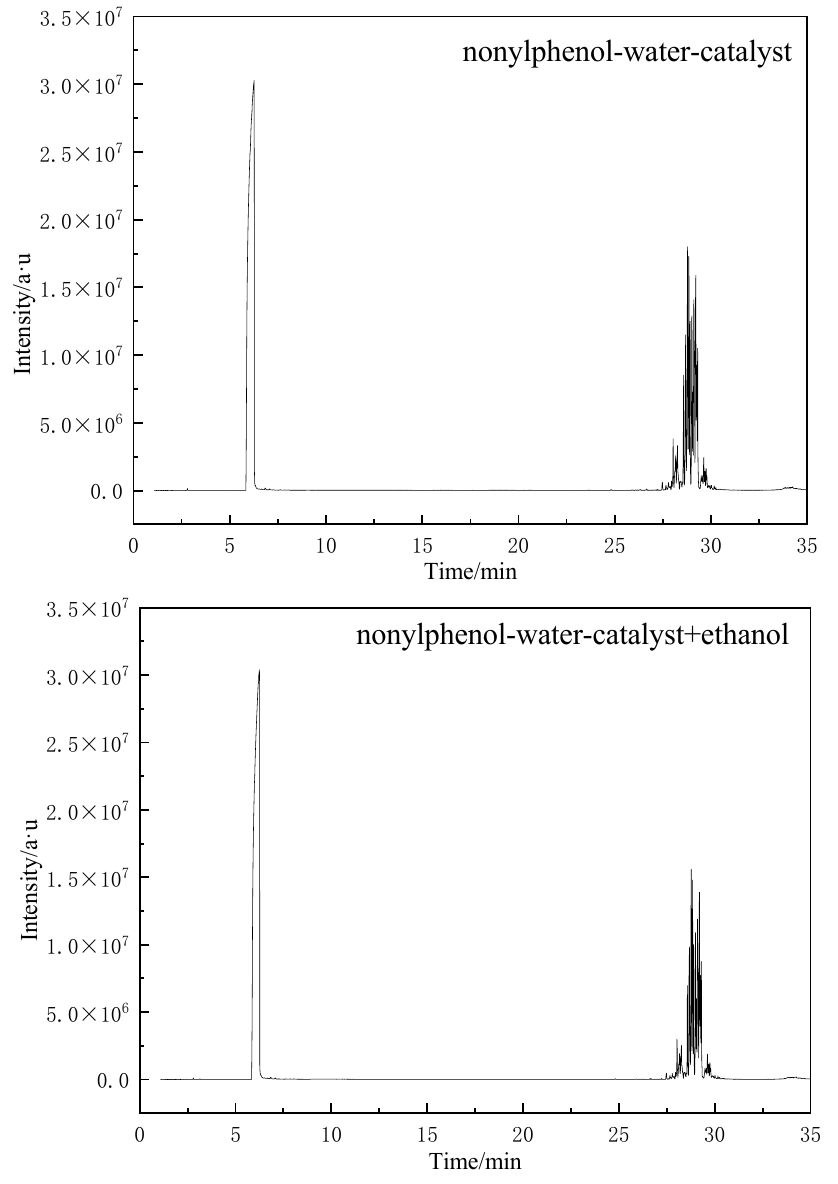
Figure 12. GC curves of nonylphenol under different reaction conditions.